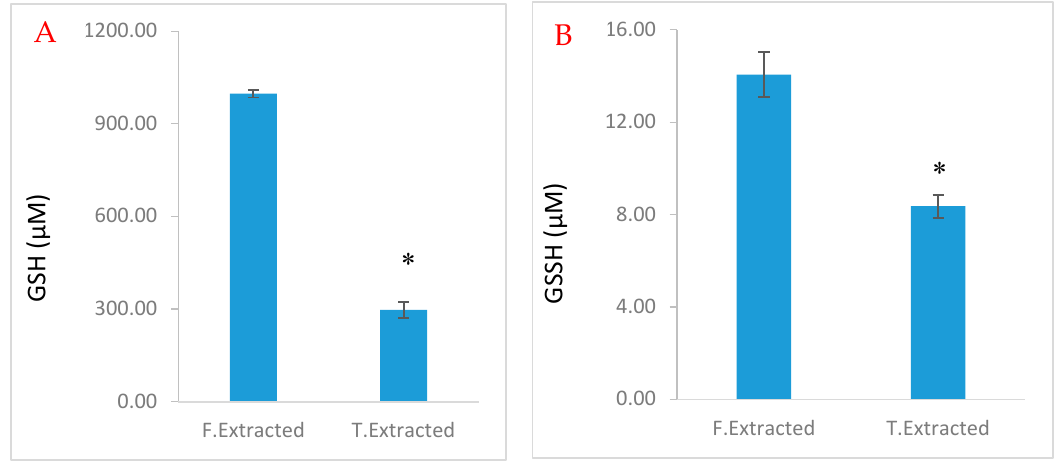
Figure 7. Degradation of blood and serum reduced glutathione (GSH) through di ff erent extraction procedures. T extract: Freshly harvested whole blood of serum was snap frozen in liquid nitrogen and stored at − 80 ◦ C for 6 weeks. On the day of the experiment, PCA was added to the frozen sample and allowed to thaw, thus extraction and thawing occurred simultaneously; F-extract: freshly harvested whole blood of serum was subjected to PCA extraction and the supernatant stored at − 80 ◦ C for 6 weeks. On the day of the experiment, the supernatant was thawed and used for the assay. ( A ) was subjected through GSH protocol; ( B ) was subjected through GSSG protocol. Data are presented as mean ± SEM ( n = 4, * p < 0.05). Data are presented as mean ± SEM ( n = 4).